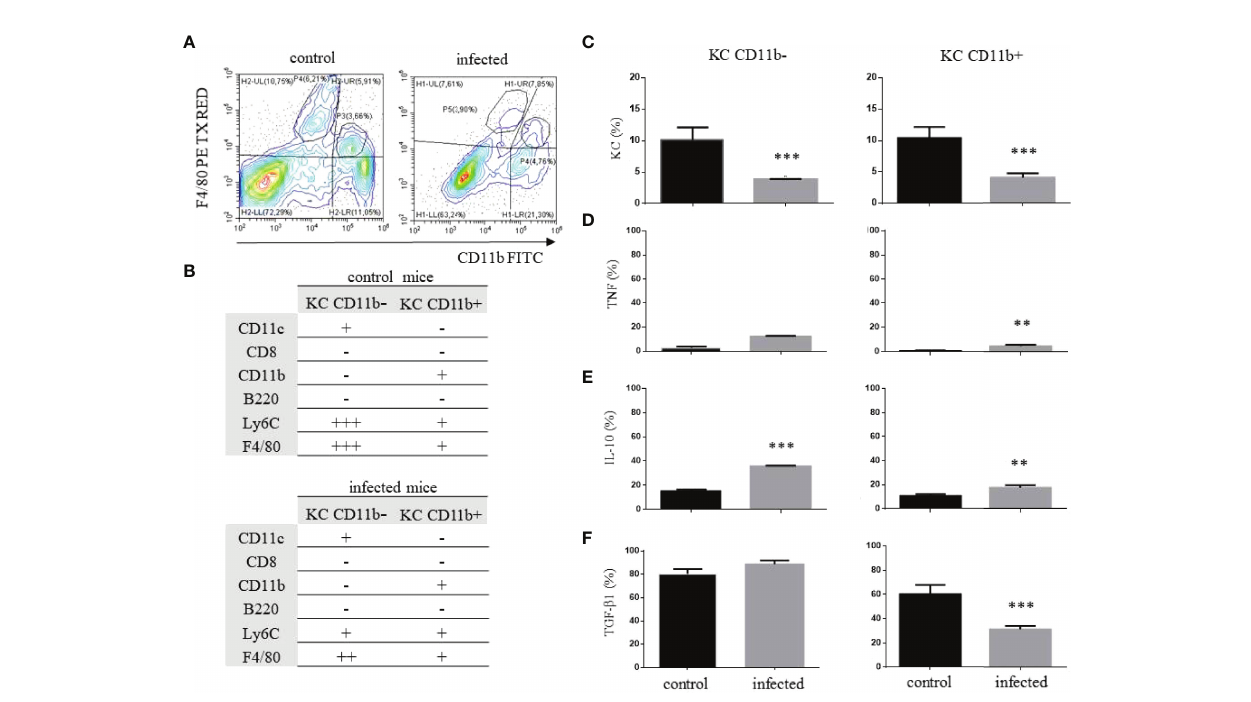
FIGURE 3 | Kupffer cell identi fi cation and phenotype after T. cruzi infection. C57BL/6 mice were infected with trypomastigote forms of T. cruzi Y strain and on dpi 15, infected and control mice were euthanized. The KCs were identi fi ed as F4/80 + and two subpopulations were depicted according to the expression of CD11b (A) . The complete phenotype to discern CD11b - and CD11b + KCs is shown in (B) and the frequency of each cellular population is shown in (C) . The frequency of each subpopulation expressing TNF- a (D) , IL-10 (E) , or TGF- b 1 (F) are indicated for control and infected mice. ** means statistical signi fi cance (p ≤ 0.05) and *** means p ≤ 0.01. We used the Kruskal Wallis test followed by Dunn ’ s post-test to analyze TNF- a and TGF- b 1 in CD11b- KC cells. We used the one-way ANOVA test followed by Tukey ’ s post-test for all other